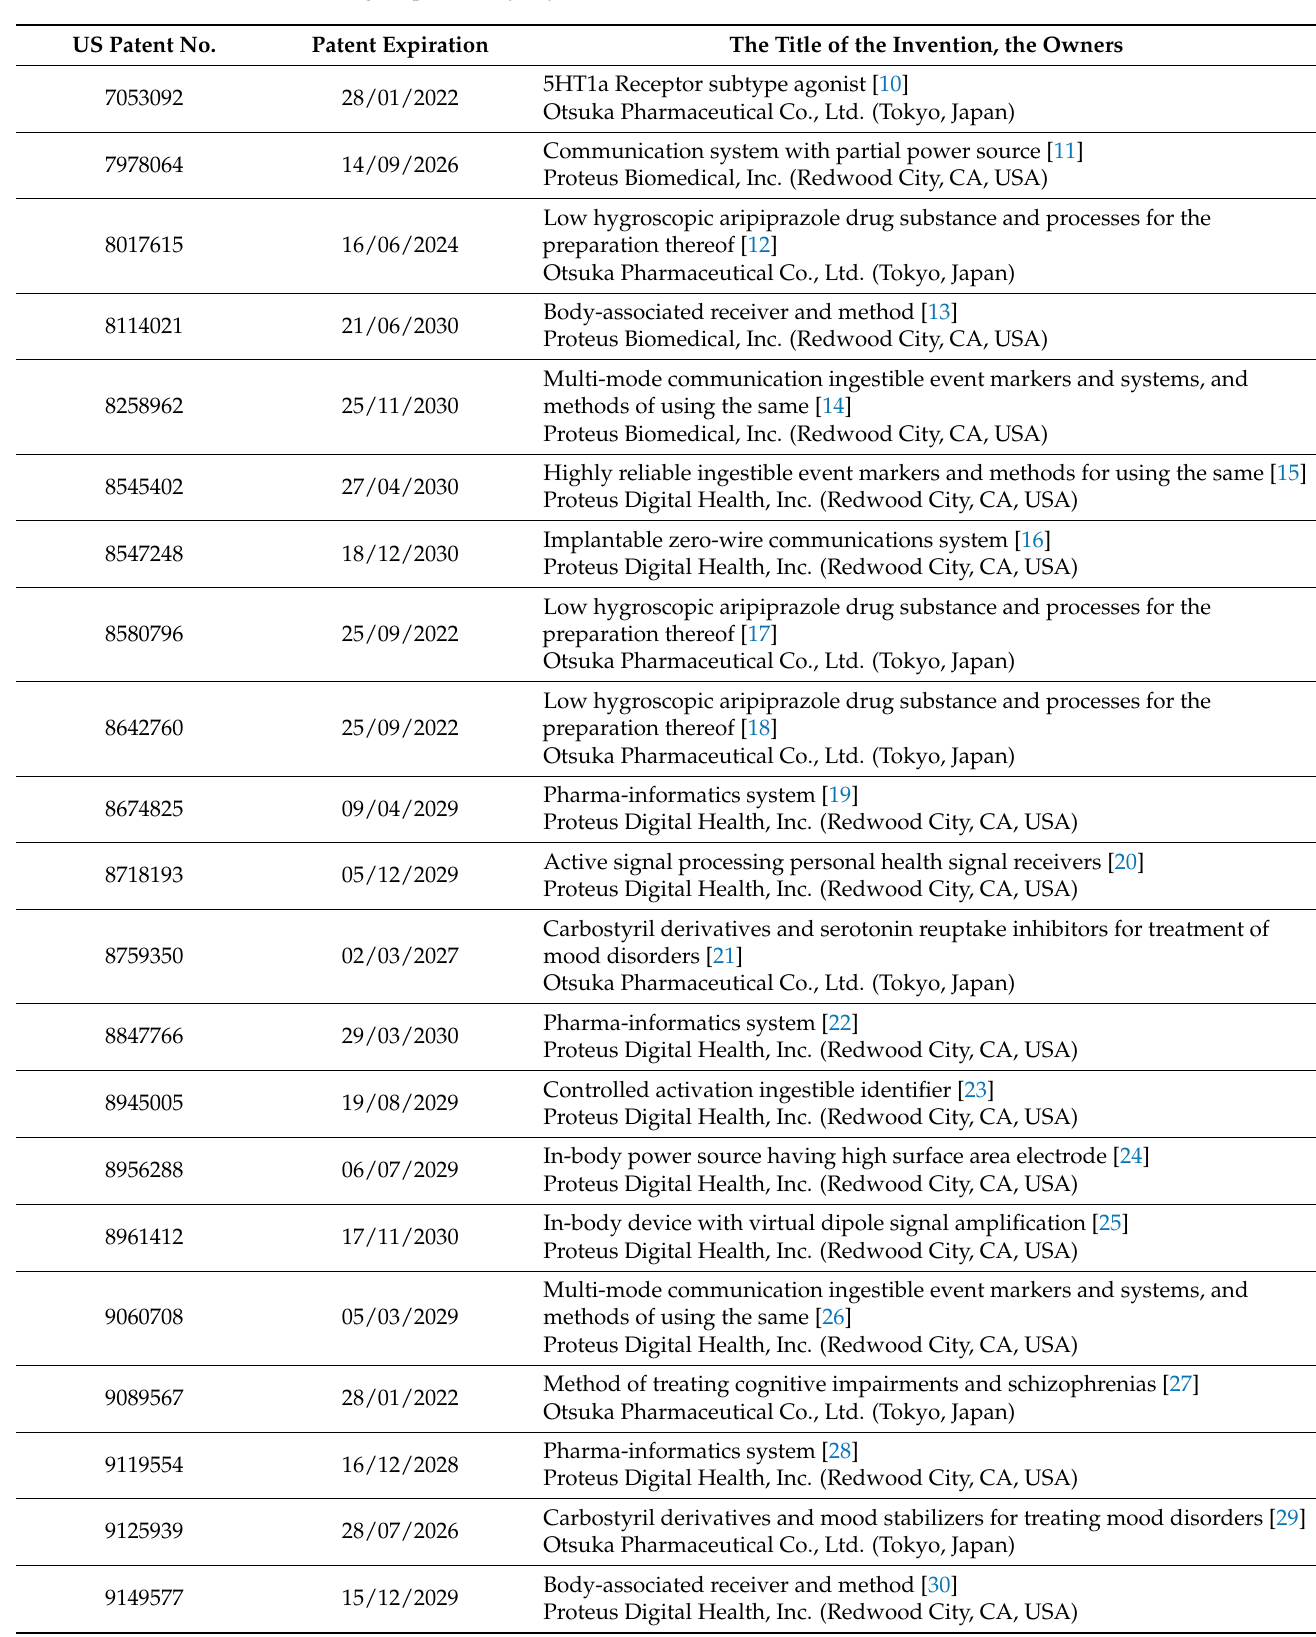
Table 1. Analysis of Proteus Digital Health and Otsuka Pharmaceutical patent strategies for the digital pill Abilify